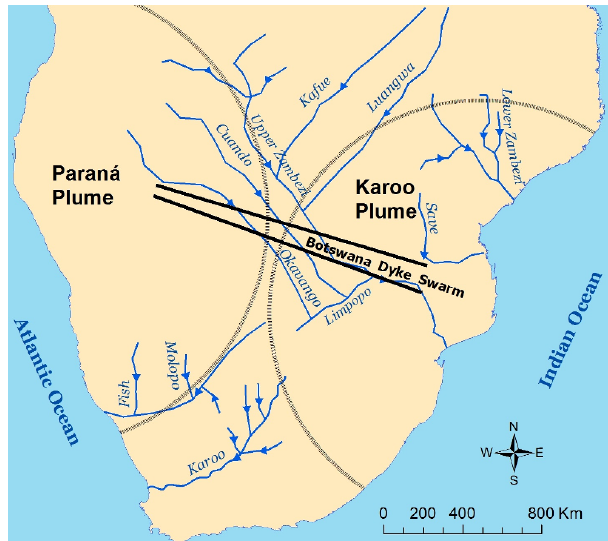
Figure 5. Main drainage system of southern Africa during the early Cretaceous period (adapted from Moore,